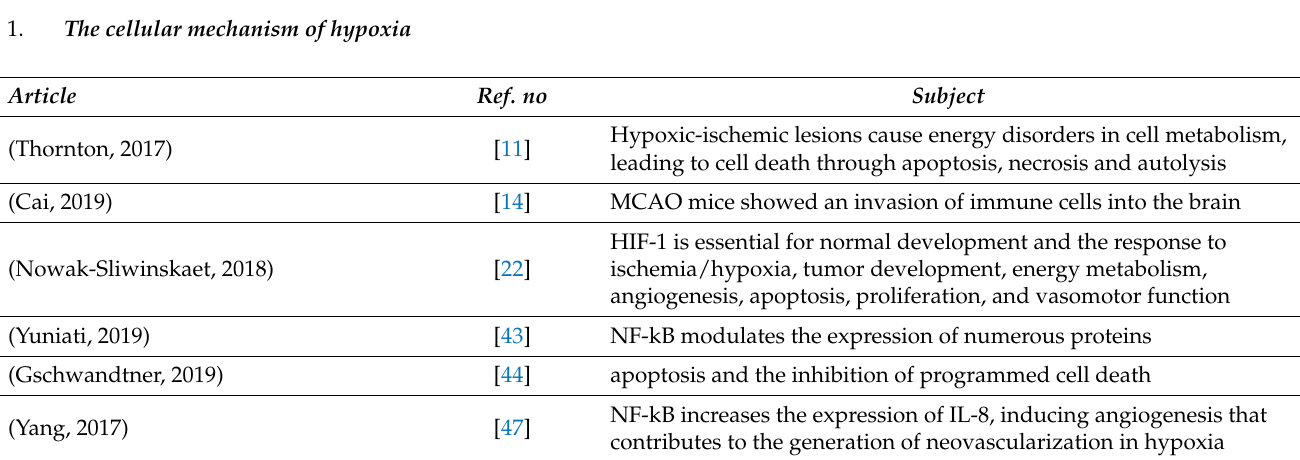
Table 1. PRISMA resulting conceptual skeleton structure of the article’s organization